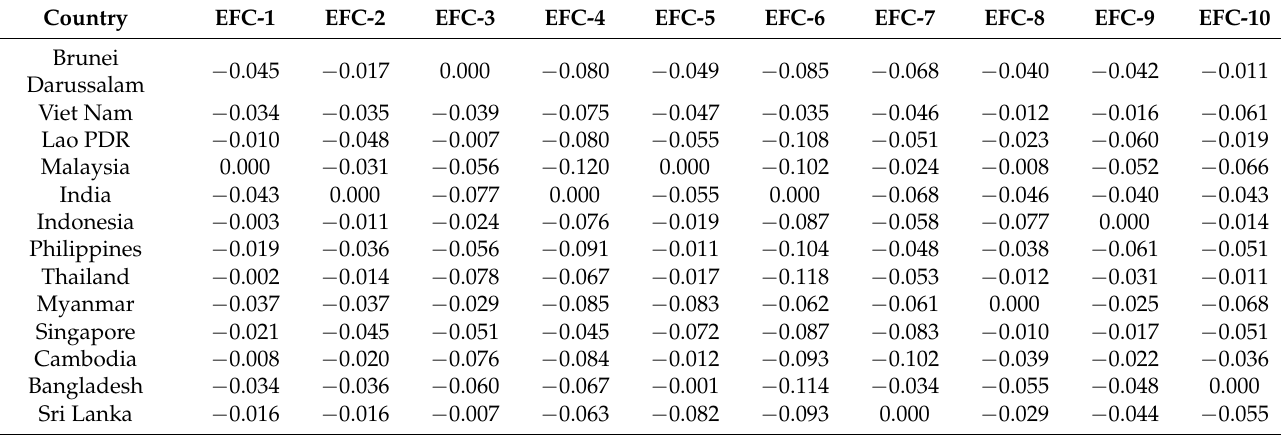
Table 7. Regret matrix.